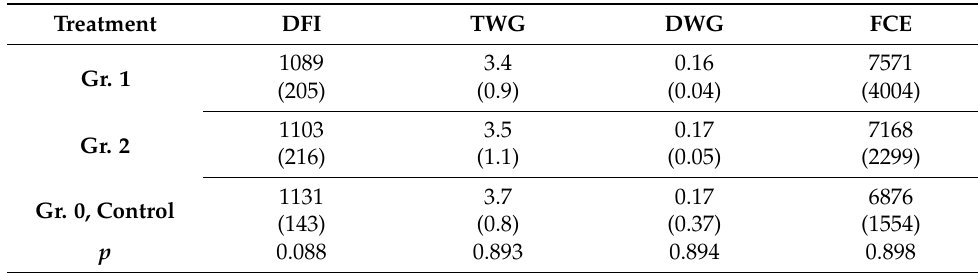
Table 3. Productive performance (means ± SD, in g) of Pelibuey lambs with different doses of Hura crepitans seeds.